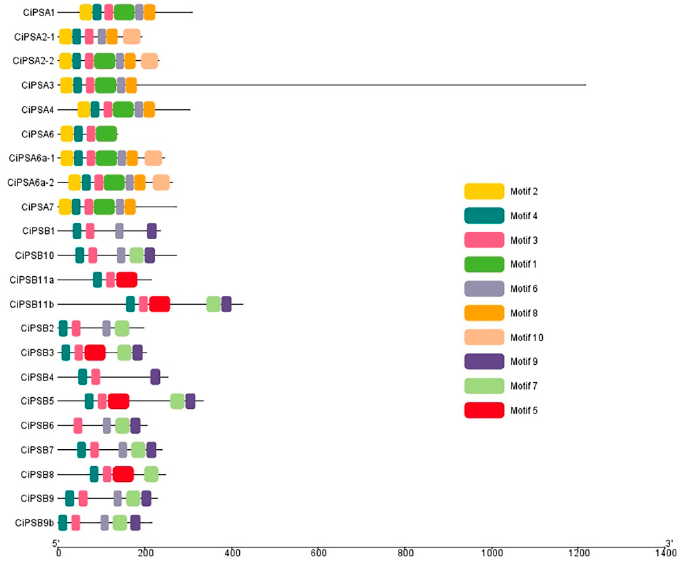
Figure 2. Distribution of conserved motifs within CiPS gene family members in grass carp.